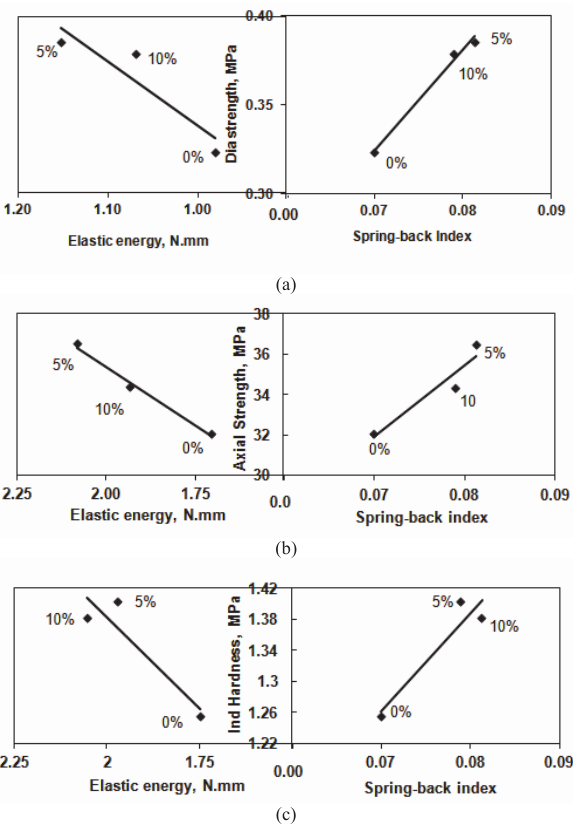
Fig. 11 Plot between elastic energy and spring-back index vs. (a) diametral strength, (b) axial pen- etration strength, and (c) indentation hardness for tablets formed at 90 MPa using dry powder formulations.